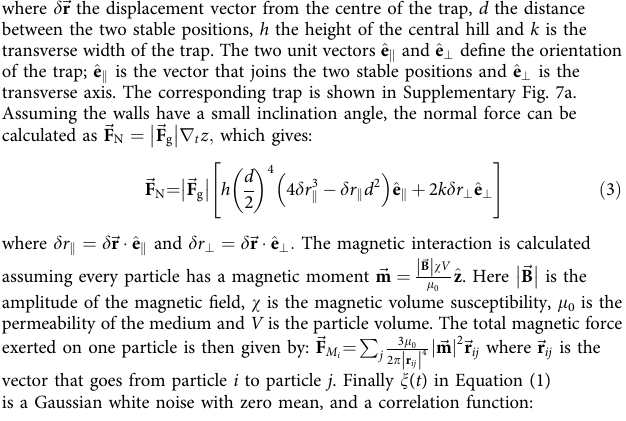
where Z is the viscous friction and ~ F tot is the sum of external forces acting on the particle, composed by three terms ~ F ext ¼ ~ F g þ ~ F N þ ~ F M . Here ~ F g is the gravitational